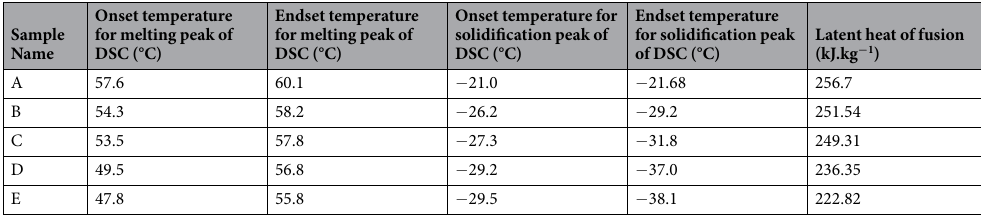
Table 2. Melting and solidification temperatures of SAT and SAT + EG composite